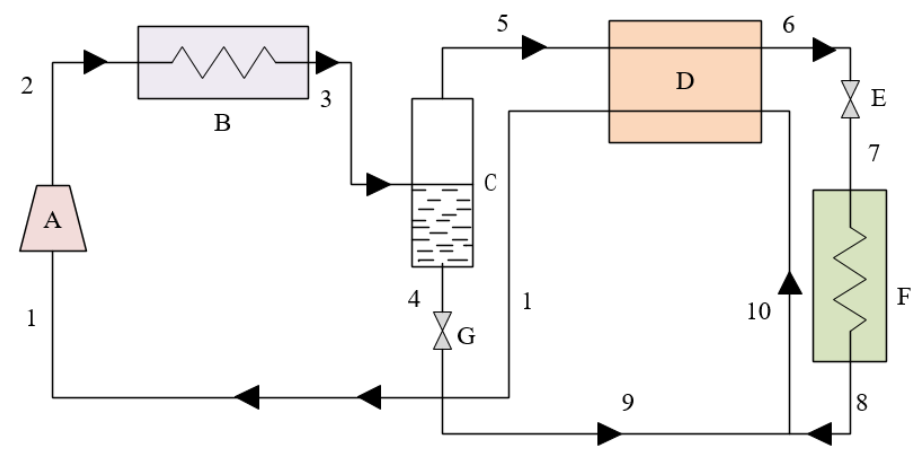
Figure 7. The process of ACR with one phase separator: A, compressor; B, condenser (after cooler); C, phase separator; D, evaporative condenser (regenerative heat exchanger); E and G, throttle valves; F, evaporator; and 1–10 node numbers in ACR cycle [83,86]. Reproduced with permission from [Elsevier], Elsevier, 2020.